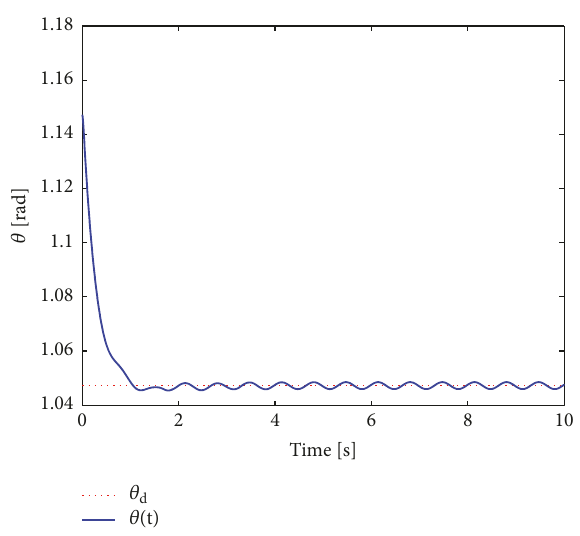
Figure 8: Control input torque 𝛾 1 (𝑡)